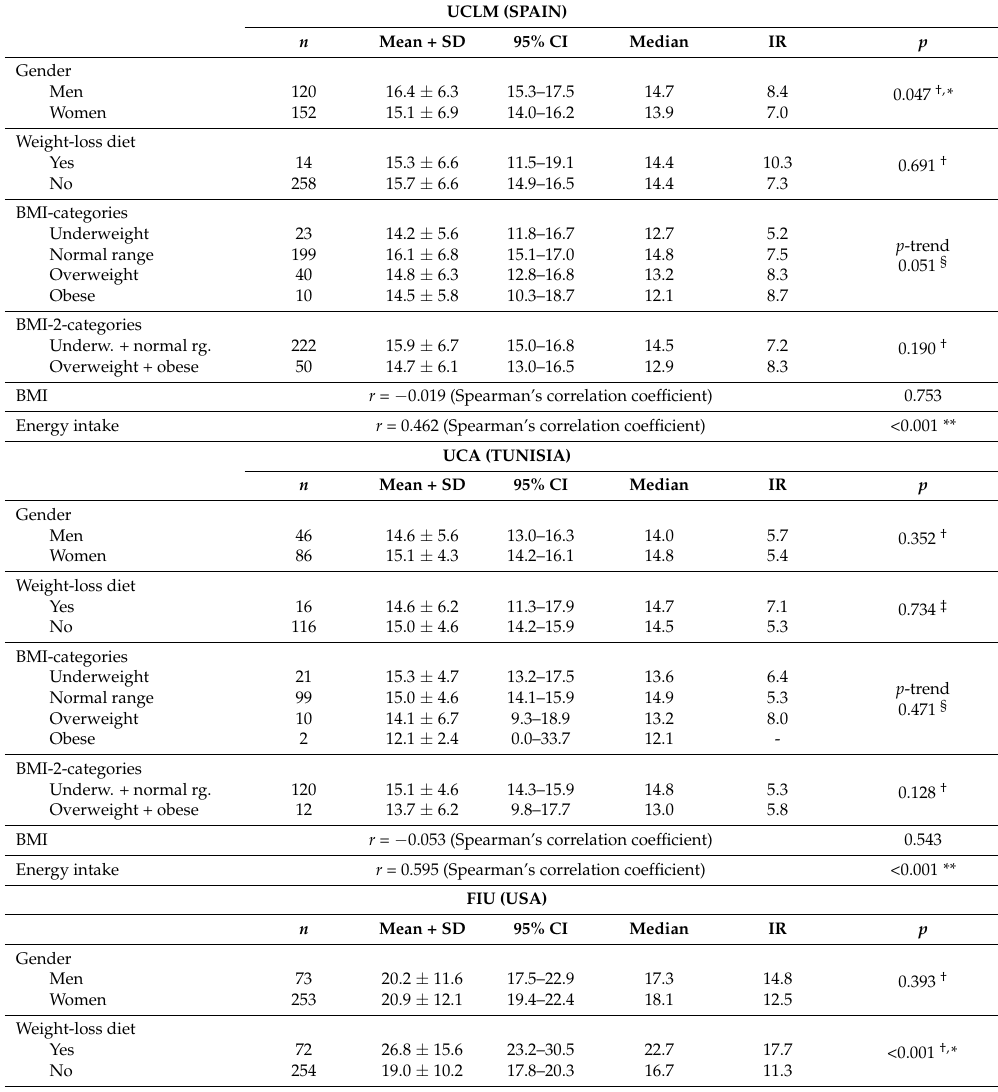
Table 4. Daily total fiber intake (g) by universities for variables presenting significant